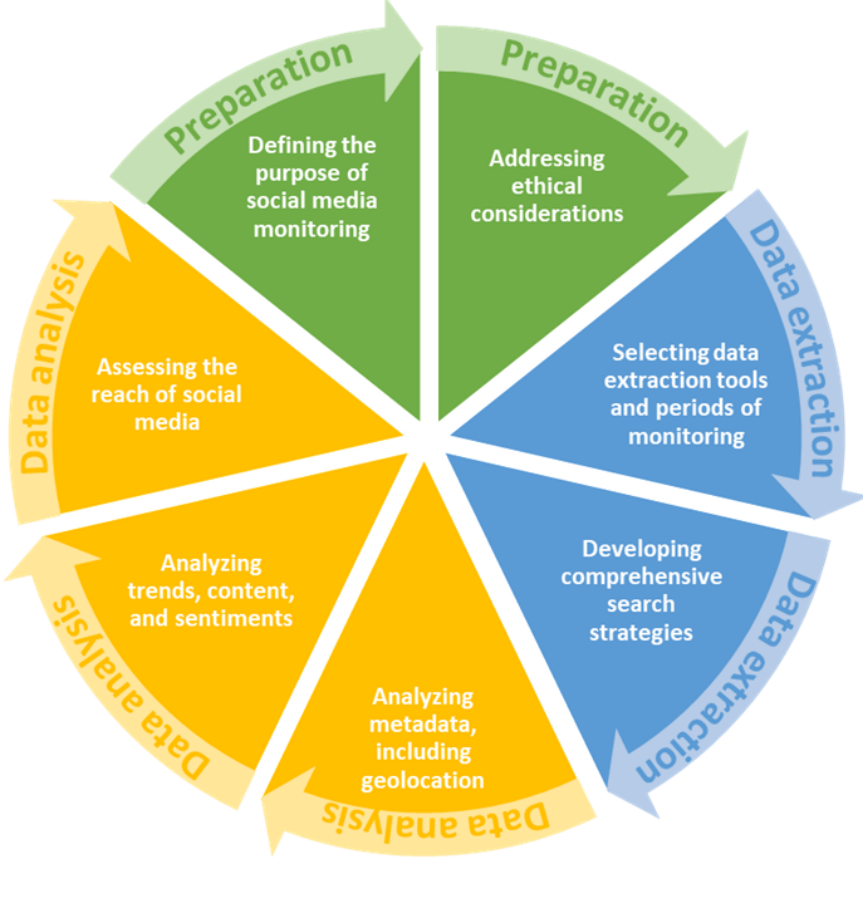
Figure 1. The three-step model of social media